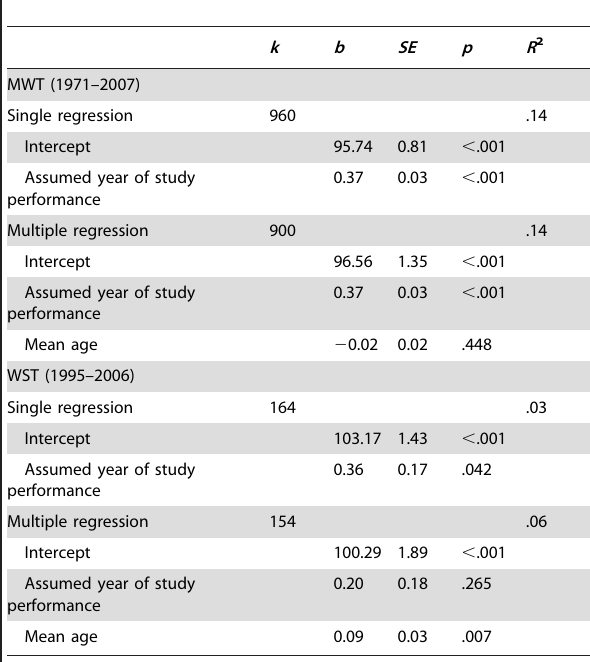
Table 1. Single and Multiple Weighted Regression Analyses for MWT and WST Scores.